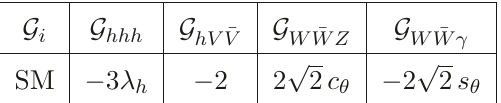
functions and the Standard Model parameters. G i